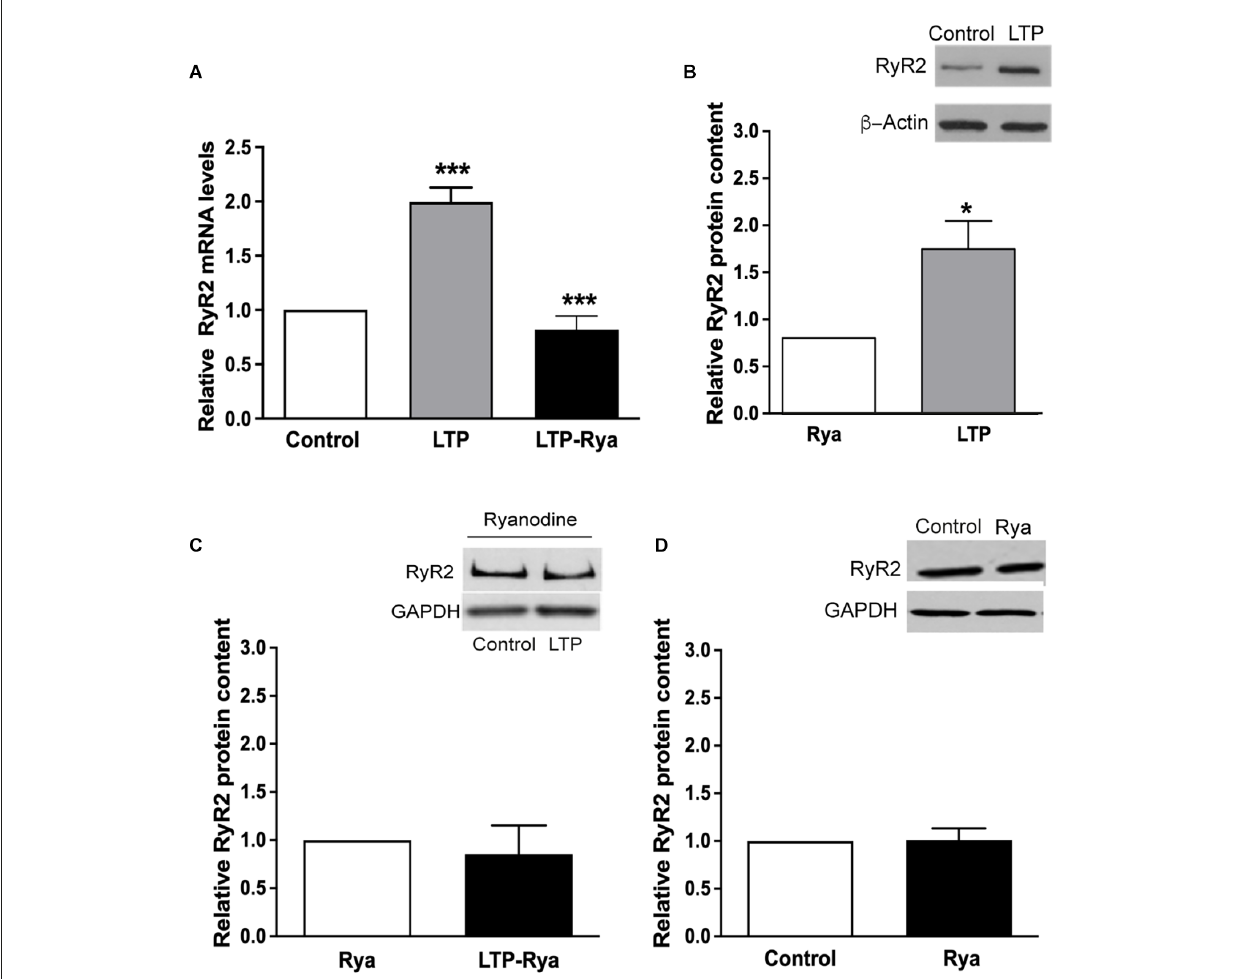
FIGURE2 Inhibitory ryanodine suppressed the LTP-induced increases in RyR2 mRNA levels and protein content. (A) qRT-PCR analysis of RyR2 mRNA levels determined 60 min after applying the TBS protocol to control slices or to slices pretreated for 1 h with 20 µ M ryanodine. The results are expressed as Mean ± SEM ( N = 4); *** p < 0.001. (B) RyR2 protein contents were determined 60 min after applying the TBS protocol to control slices or to slices preincubated for 1 h with 20 µ M ryanodine. The results are expressed as Mean ± SEM ( N = 4); * p < 0.05. (C) RyR2 protein contents were determined in slices pretreated for 1 h with 20 µ M ryanodine; values were determined after 60 min in slices exposed only to basal stimulation or to the TBS protocol. (D) RyR2 protein contents were determined in unstimulated slices; results illustrate the RyR2 protein contents in control slices or in slices preincubated for 1 h with 20 µ M ryanodine. In (C) and (D) , the results are expressed as Mean ± SEM, ( N = 4); differences were not statistically significant. The statistical analysis was performed with one-way ANOVA followed by Tuckey’s multiple comparisons post-hoc test (A) and with two-tailed Student’s paired t -test (B,C,D)